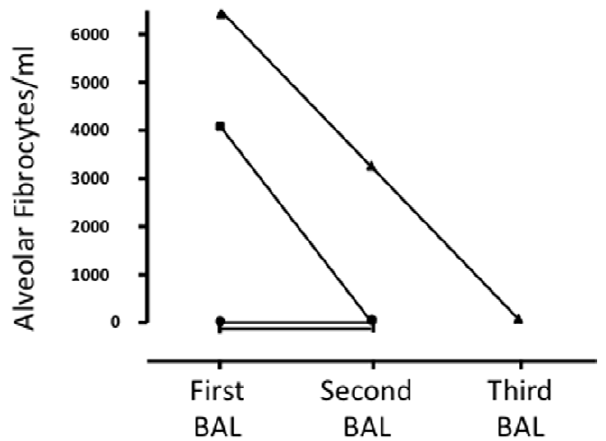
Figure 4. Evolution of the number of alveolar fibrocytes in 4 patients with IPF where bronchoalveolar lavage fluid was obtained at two or more occasions. Alveolar fibrocytes were no more detectable in the 2 patients with initial detectable alveolar fibrocytes. In the 2 patients without detectable alveolar fibrocytes at initial evaluation, fibrocytes remained undetectable in subsequent broncholveolar lavage fluid analysis.